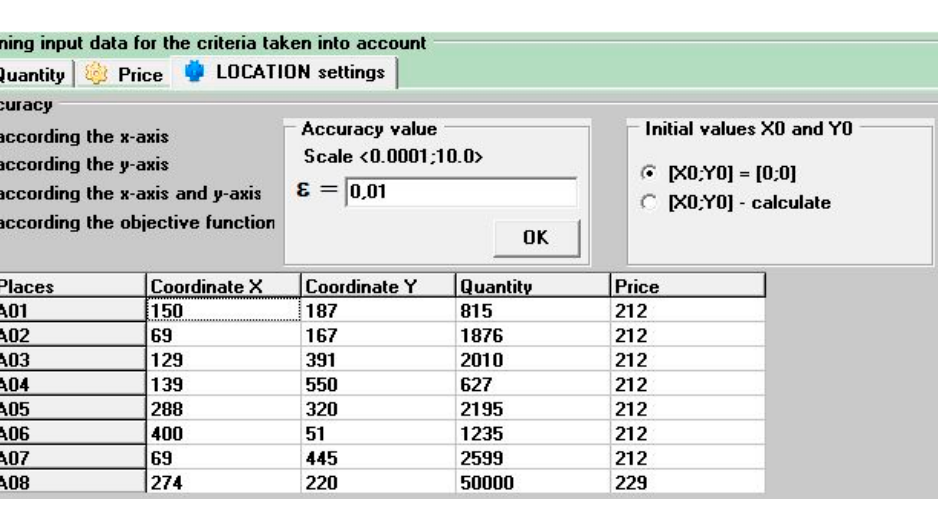
Figure 15. Setting the required location calculation parameters, and the parameters of the raw material quantities and unit prices to be inserted into the expert system.